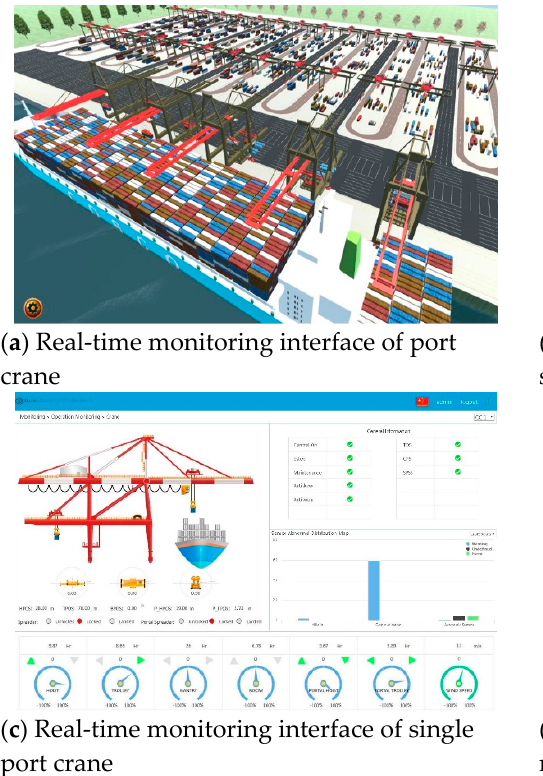
Figure 7. Application interfaces of CHMS.